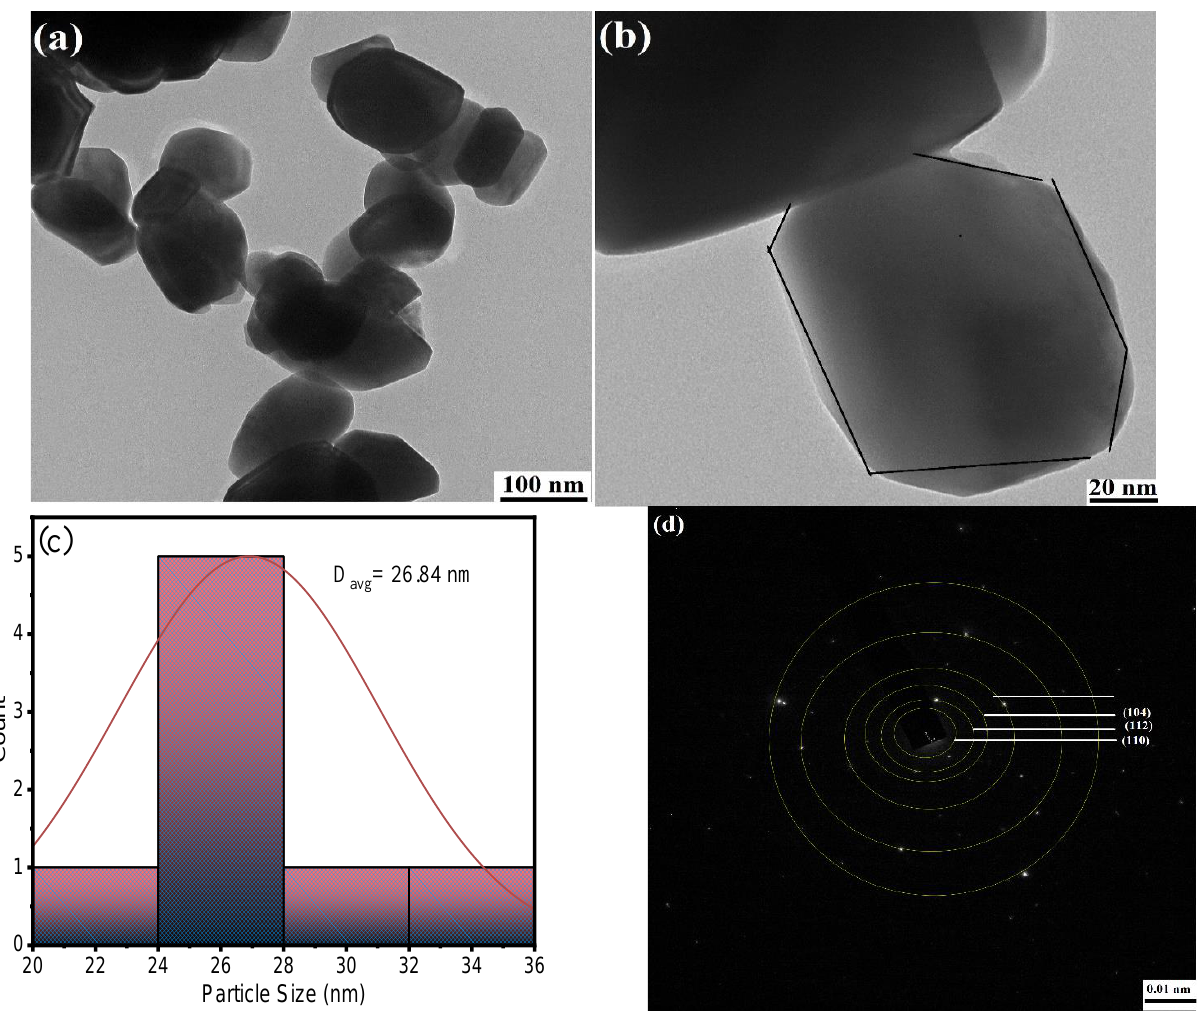
Figure 5. ( a , b ) TEM images of Ni 1 − x Mn x WO 4 NC at 100 and 20 nm magnification range, ( c ) Gaussian average particle size distribution, and ( d ) SAED pattern showing the Debye – Scherer rings.